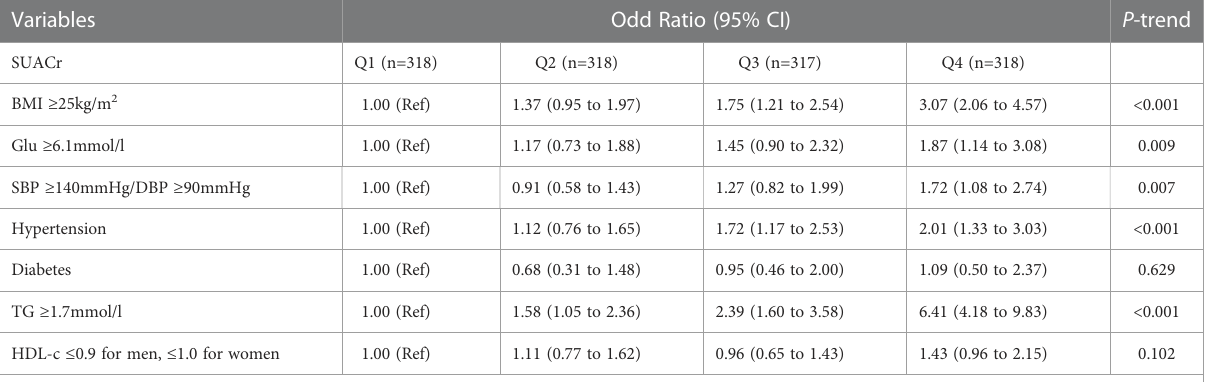
TABLE 5 Associations of the SUACr levels with the components of MetS.